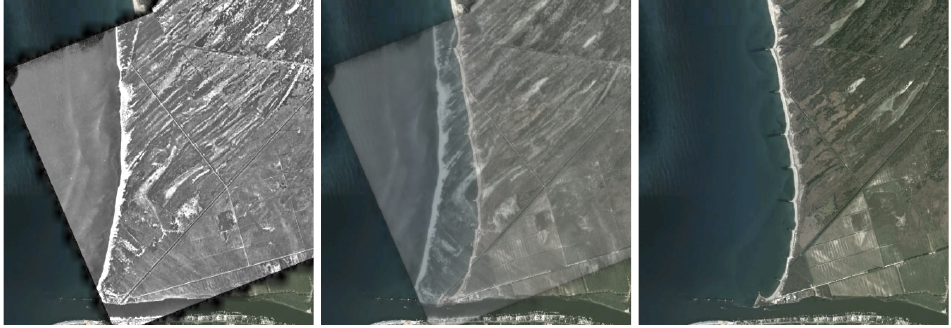
Figure 12. Snapshots from the application showing the mouth of the river Arno close to Pisa. Left : A historical photo from 1943. Middle : The blending process in action. Right : Google Earth photo (2012). One can notice how the beach has been overtaken by the sea on the north side of the river ( c (cid:13) MiBAC-ICCD, Aerofototeca Nazionale, fondo RAF. c (cid:13) 2010 Google).